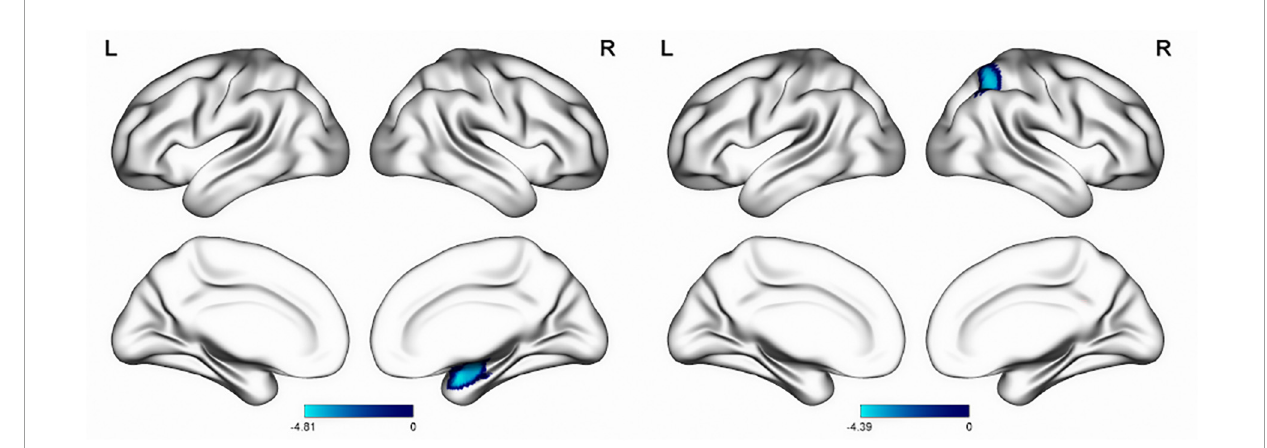
FIGURE3 Inter-group differences in VBM (left) and CBF (right) values. The blue area of the color bar represents brain areas with decreased VBM and CBF values. VBM, voxel-based morphometry; CBF, cerebral blood flow.